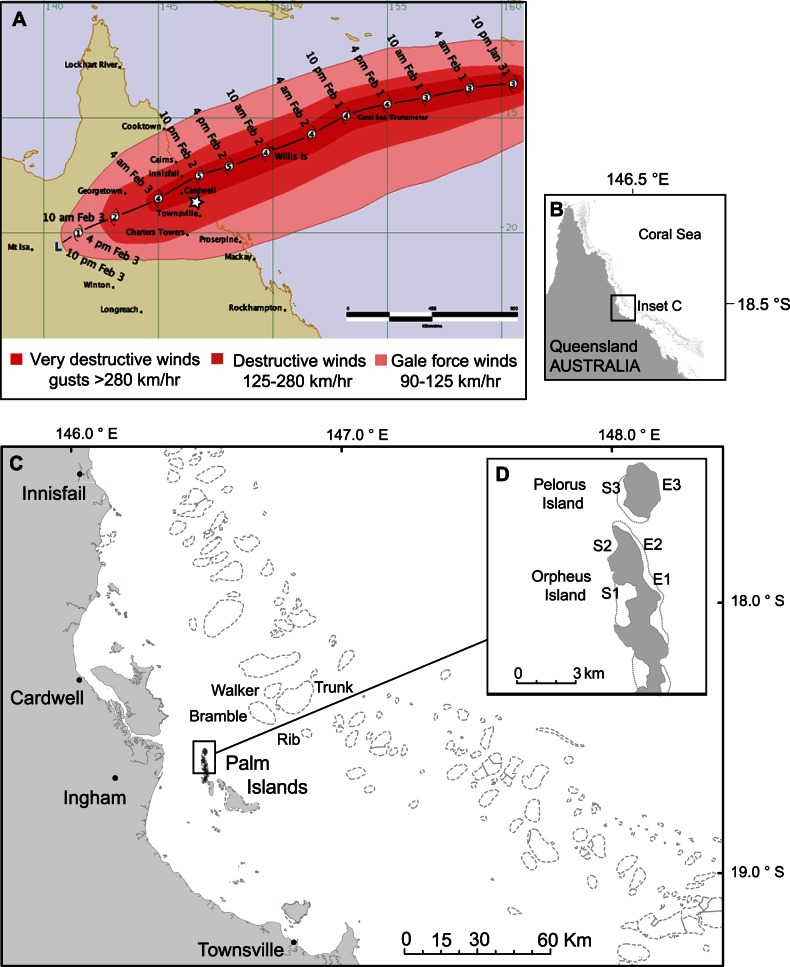
The path of severe tropical cyclone Yasi in relation to the Palm Islands, central Great Barrier Reef (GBR).
A. Track of cyclone Yasi crossing the GBR on February 2nd, 2011 (source www.bom.gov.au/cyclone/history/yasi.shtml#track accessed on June 5th, 2012). Star indicates Palm Islands. B. Location of the Palm Islands on the GBR. C. Locations of Palm Islands and adjacent mid shelf reefs in the central GBR. D. Locations of exposed and sheltered study sites at Orpheus and Pelorus Islands in the Palm Islands.